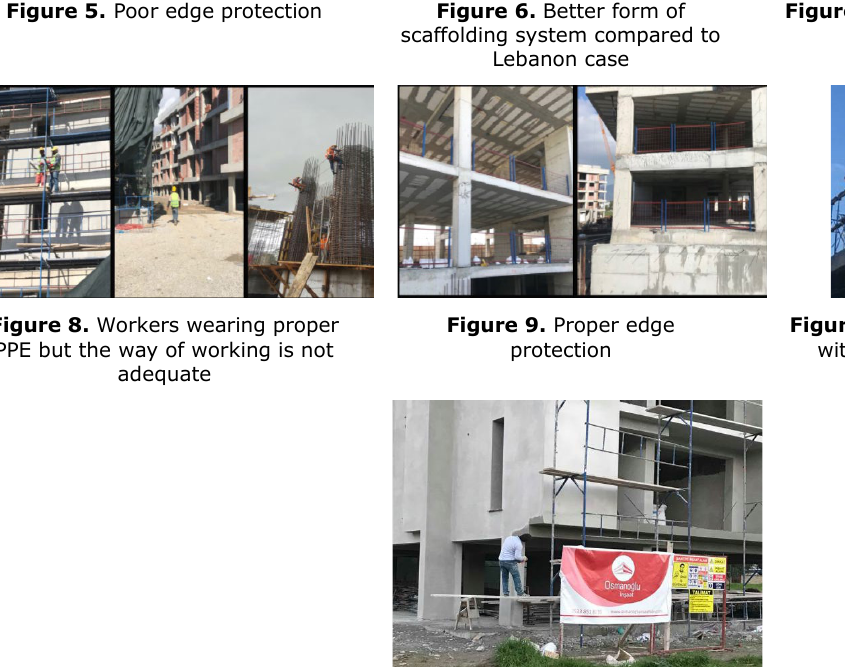
Figure 5. Poor edge protection Figure 6. Better form of